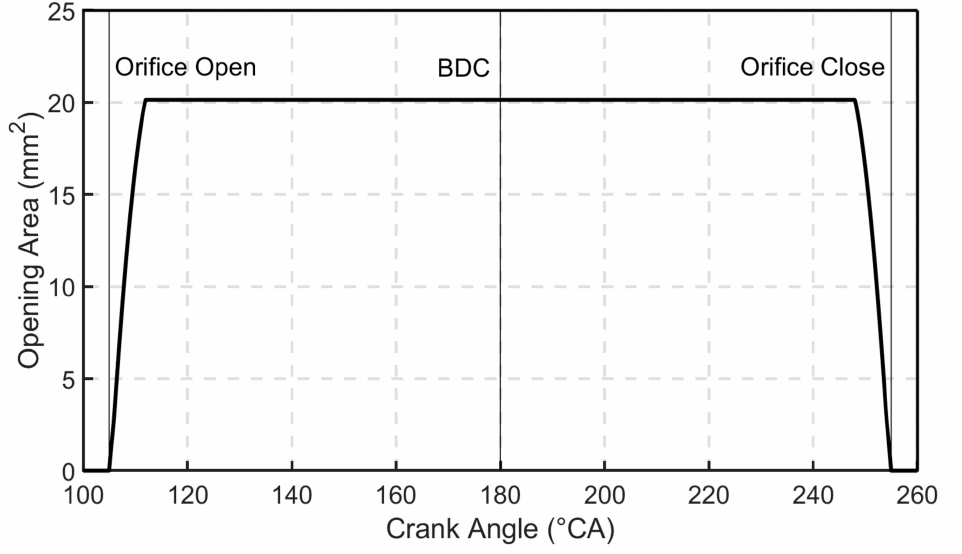
Figure 24. The variation curve of opening area with crank angle (connecting